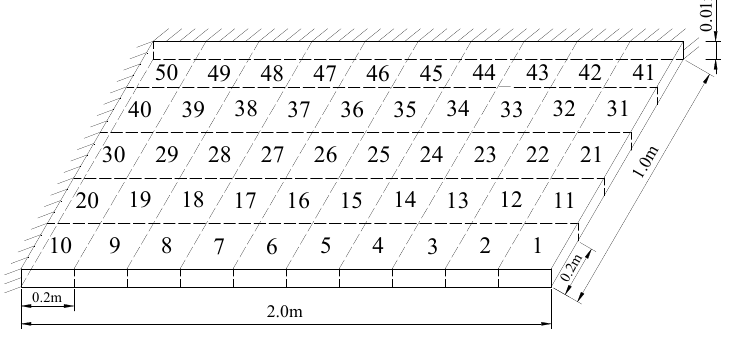
Figure 18. A plate structure. Figure 18. A plate